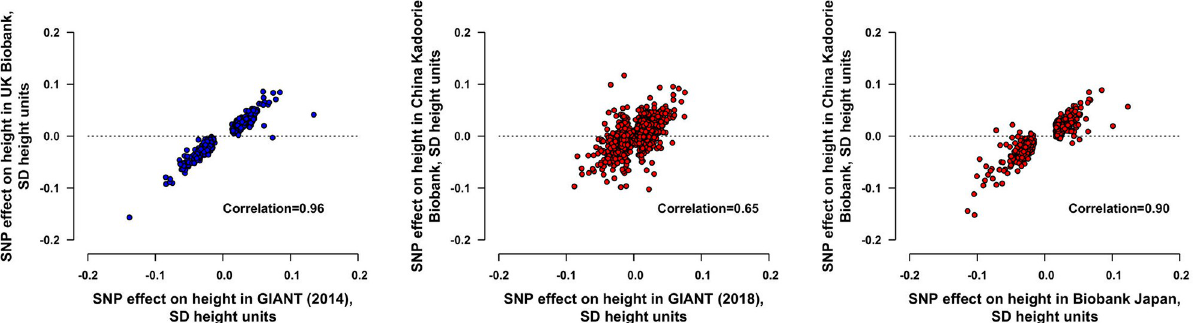
Fig 1. Effects of height-associated SNPs on height in UKB and CKB. For UKB (336,750 participants), the effects on height were estimated for 641 SNPs from GIANT (2014) [19]. For CKB (53,346 participants), the effects on height were estimated for 2,189/2,337 SNPs from GIANT (2018) [18] and 499/517 SNPs from Biobank Japan [20] with minor allele frequency � 0.005 in CKB. The effect sizes on height were adjusted for age, age 2 , sex, region (in CKB only), genomic principal components, and genotyping array type. SNPs with minor allele frequencies of < 0.005 were not shown. In UKB, the genetic risk score explained 17.0% of the variance of height and, in CKB, the genetic risk scores from GIANT (2018) [18], Biobank Japan [20], and the average genetic risk score, respectively, explained 11.4%, 11.0%, and 15.2% of the variance of height. C AU : AbbreviationlistshavebeencompiledforthoseusedthroughoutFigs 1 (cid:0) 3 : Pleaseverifythatallentriesarecorrect : KB, China Kadoorie Biobank; GIANT, Genetic Investigation of Anthropometric Traits; SD, standard deviation; SNP, single nucleotide polymorphism; UKB, UK